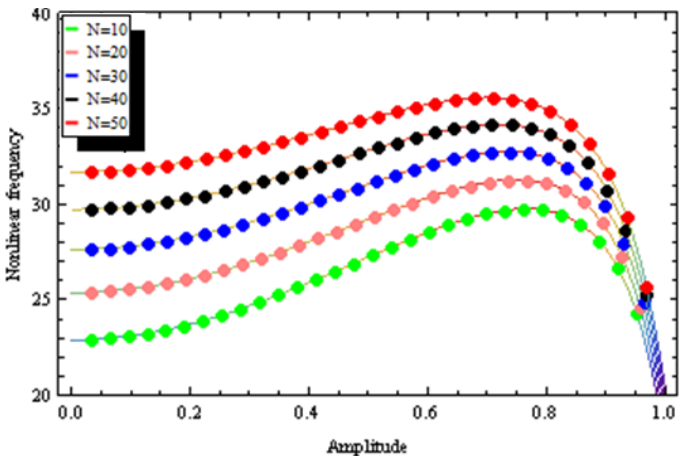
Figure 3. Effect of parameter N on the nonlinear frequency of electrostatically actuated micro-beam.